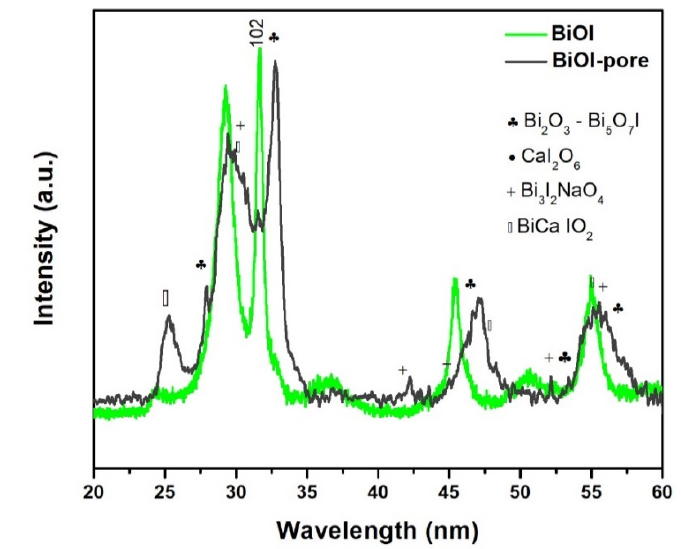
Figure 4. XRD pattern of BiOI photocatalyst before and after two weeks of contact with alkaline pH synthetic cement-pore solution (BiOI-pore).